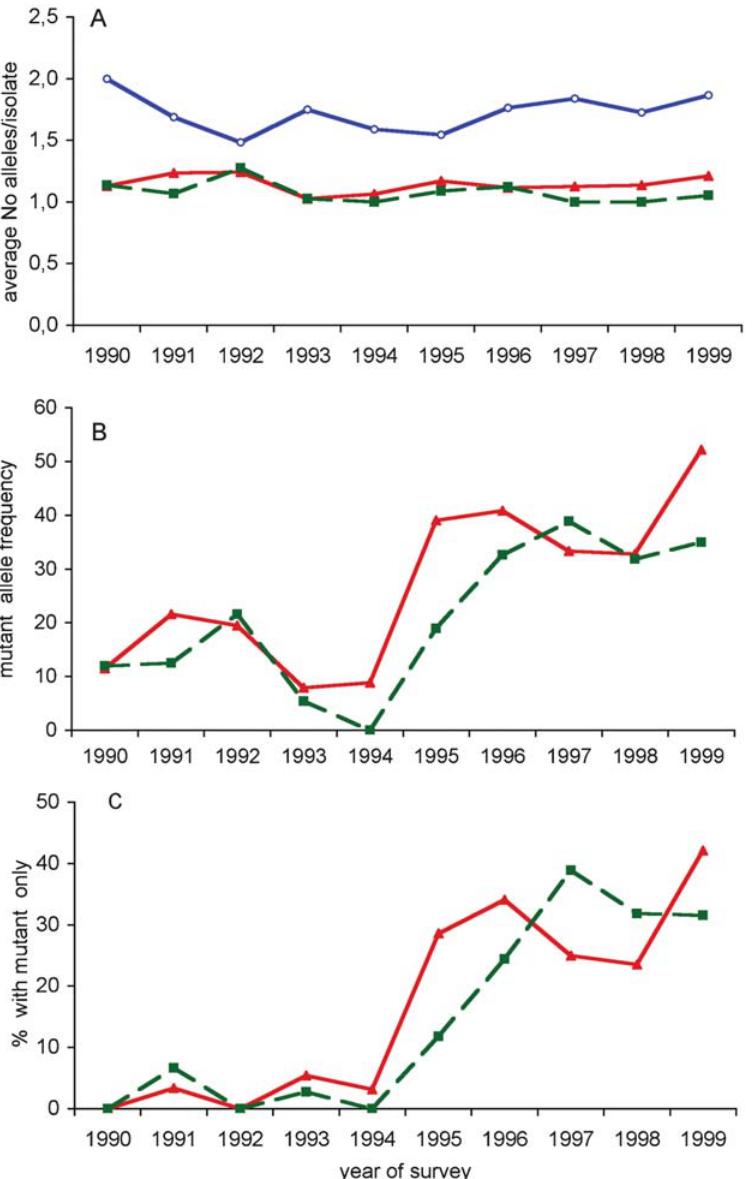
Figure 2. Temporal variation of the multiplicity of infection in Dielmo (A), frequency of Pfcrt codon 76 and Pfdhfr-tscodon 108 genotypes (B) and frequency of infections with only mutant type detected (C). The number of isolates typed at each locus is indicated in Table 1. (A). Multiplicity of infection is depicted separately for each locus. For Pfmsp1 block2, the figures derive from nested PCR analysis using family-specific primers and allele identification based on allelic family assignment and size polymorphism. For Pfcrt and Pfdfhr-ts , it is based on K76T and S108N genotypes determined by molecular beacons, respectively. Symbols used: (Red triangles): Pfcrt codon 76 genotype; (green squares): Pfdhr-ts codon 108 genotype, (blue open circles) Pfmsp1 block2. B) Allelic frequency of resistance genotypes, calculated as percentage of mutant genotype within the total number of alleles detected for each locus. Symbols used as in A. C) Percentage of isolates containing only the mutant type. Symbols used as in A.